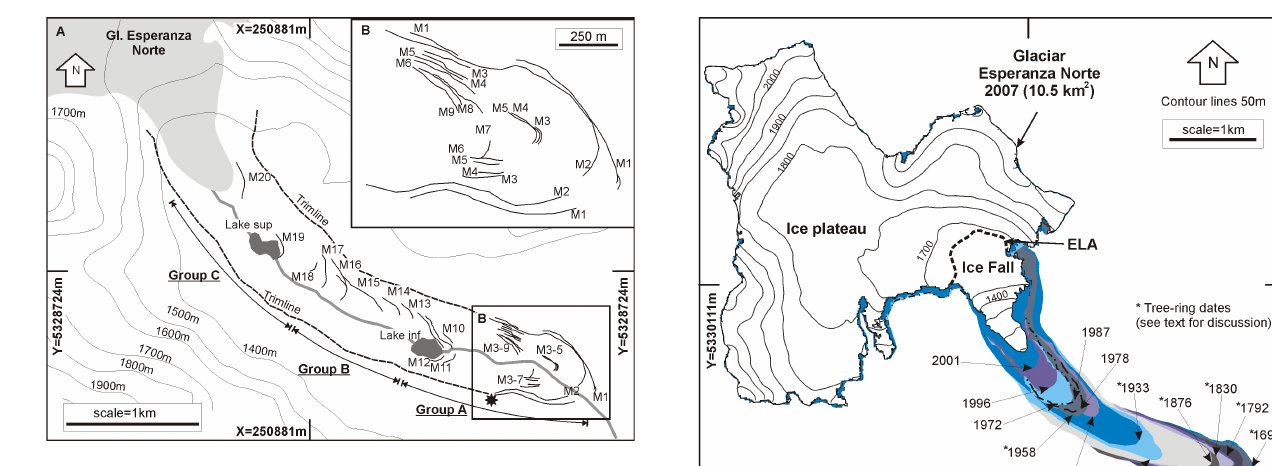
Fig. 4. (A) Simplified geomorphological map of the upper Esper- anza Norte valley. Moraine crests are shown as black lines, moraine groups are also shown. The black asterisk shows the location from where the panorama view of Fig. 2 was taken. (B) A closer view of the moraines associated with the maximum LIA glacier extent. Coordinates X and Y in UTM 19 S WGS84 projection.